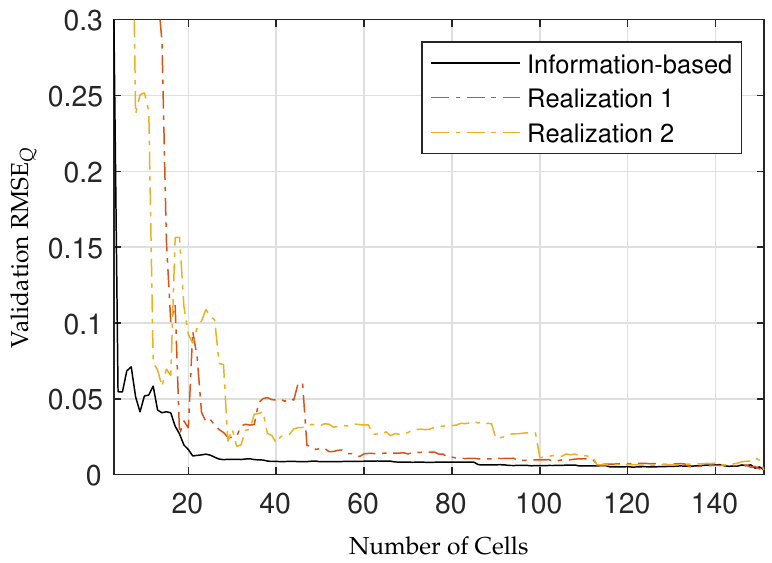
Figure 9. RMSE on validation set when D-optimal selection is done compared to random realiza- Figure 9. RMSE of the validation set when D-optimal selection was done compared to random reali- tions. sations.